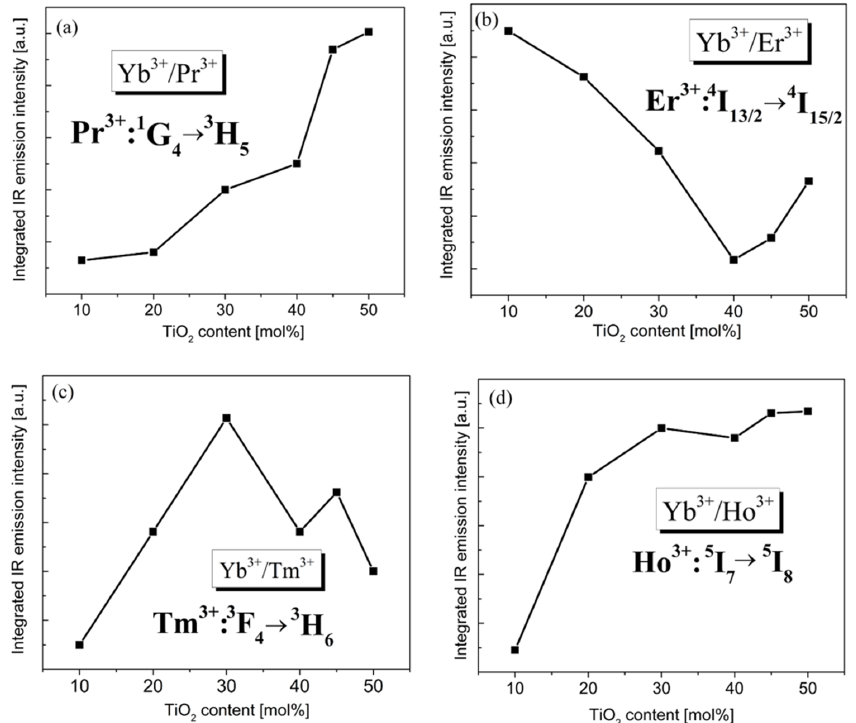
Figure 6. The integrated intensities of emission bands of rare ‐ earth ions Yb 3+ /Pr 3+ ( a ), Yb 3+ /Er 3+ ( b ), Yb 3+ /Tm 3+ ( c ) and Yb 3+ /Ho 3+ ( d ) vary with TiO 2